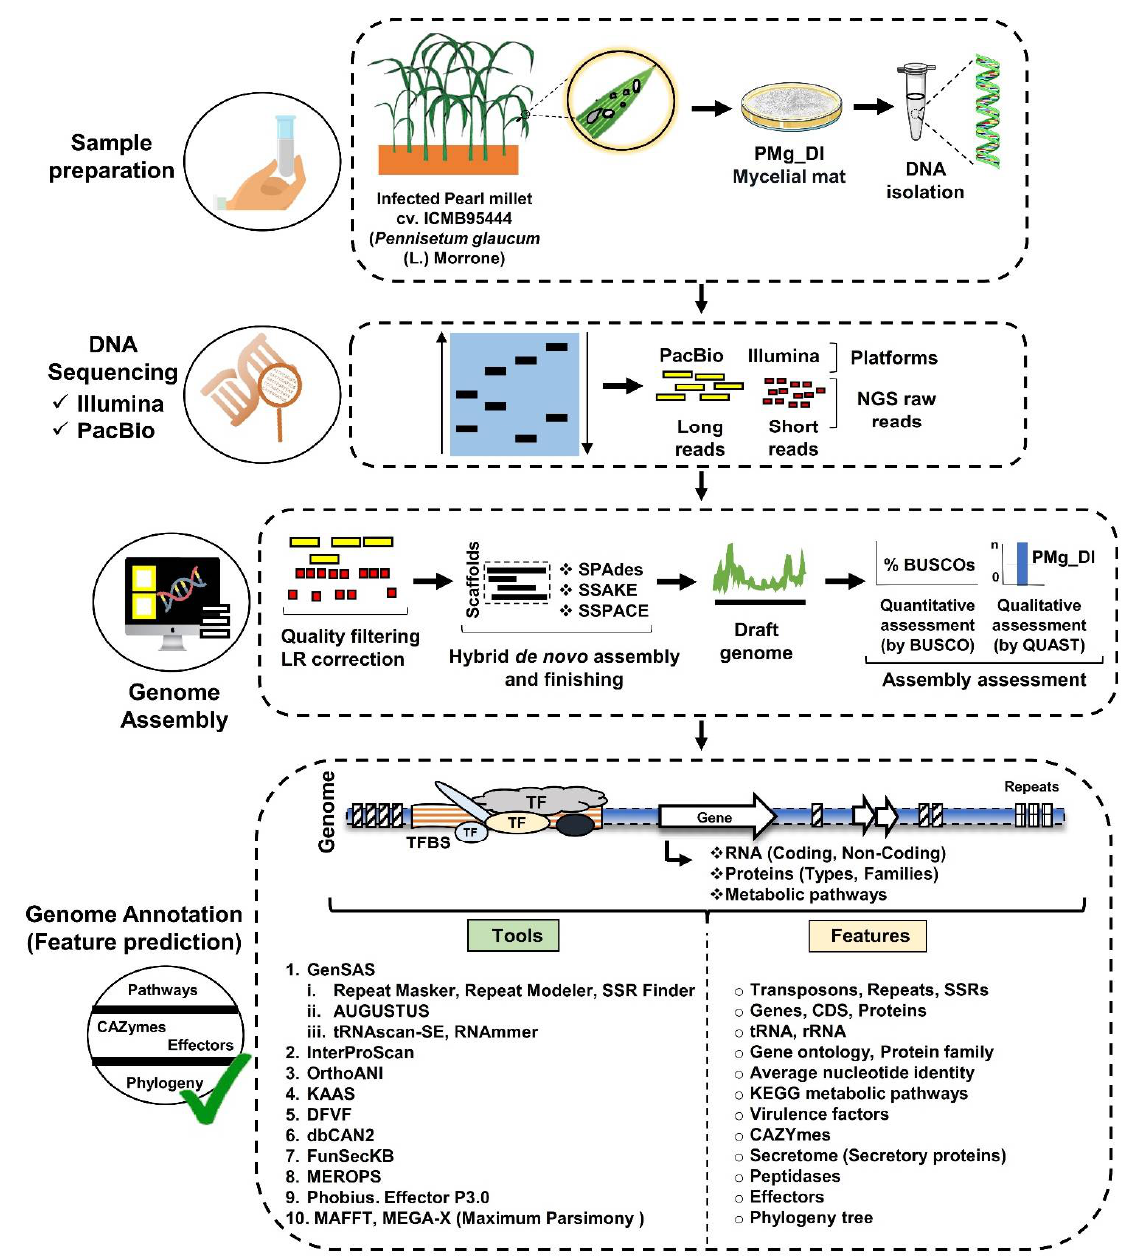
Figure 1. Schematic illustration of WGS analysis pipeline used for revealing versatile metabolic pathways, protein families, and virulence factors in M. grisea strain PMg_Dl. The entire pipeline was divided into four sequential major steps (Sample preparation, DNA sequencing, Genome Assembly, and Genome annotation). In the first step, the fungus was isolated from peal millet cultivar ICMB95444 showing blast lesion symptoms using a modified spore drop method. Following the isolation, the fungal genomic DNA was extracted. In the second step, the fungal DNA was subjected to sequencing library preparation followed by Illumina NextSeq 500 (2 × 150 bp chemistry) and PacBio RS II platform (P6-C4 chemistry) for generating short and long reads, respectively. In the third step, the draft genome was assembled using a series of tools and software after quality filtering. In the last step, functional genome annotation was performed to predict several characteristics of the M. grisea genome such as tRNA and rRNA presence, simple sequence repeats superfamily, signal peptides, gene ontology, metabolic pathways, CAZymes, secretory proteins, proteolytic proteins, potential effectors, and virulence factors. In addition, the phylogeny of M. grisea strain PMg_Dl was also